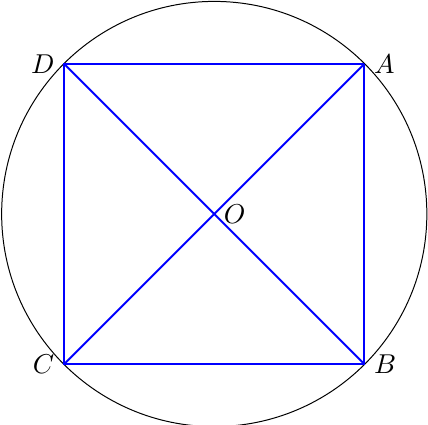
Figure 15. Illustration of our procedure for constructing a network whose minimal lengths ap- proximate those of a given geometry. The example shown constructs a network with four boundary legs which approximates a disk shaped region of R 2 . In the first step, four boundary points are chosen and all of the minimal cuts anchored on those points are drawn. The minimal cuts form a planar graph, in this example the graph has vertices A, B, C, D and O